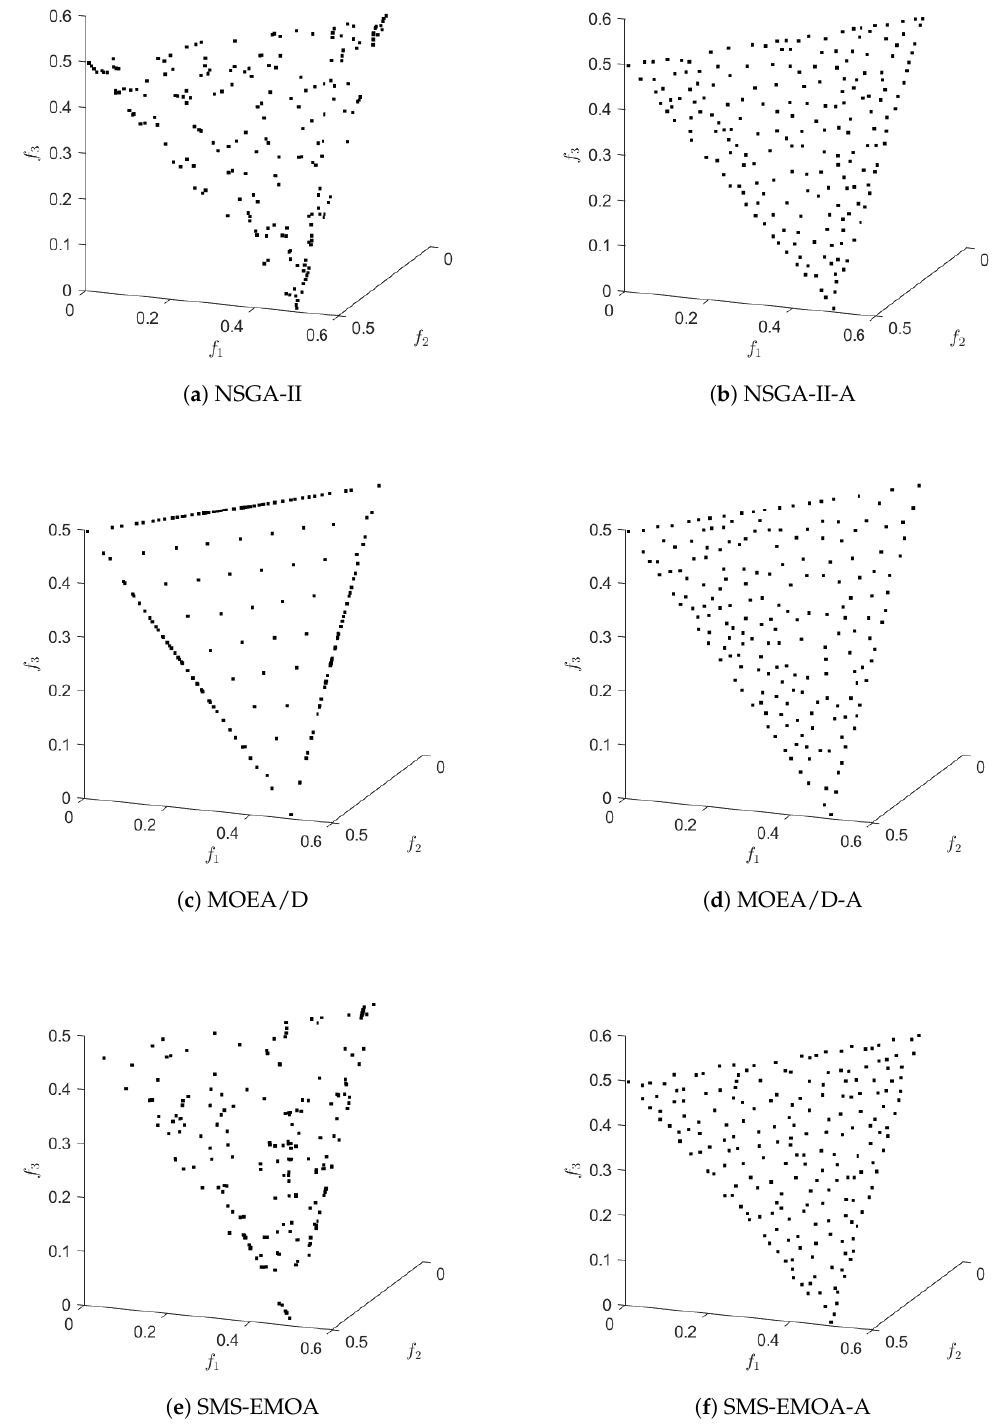
Figure A5. Numerical results of the different algorithms and archiving/selection strategies on IDTLZ1 for k =